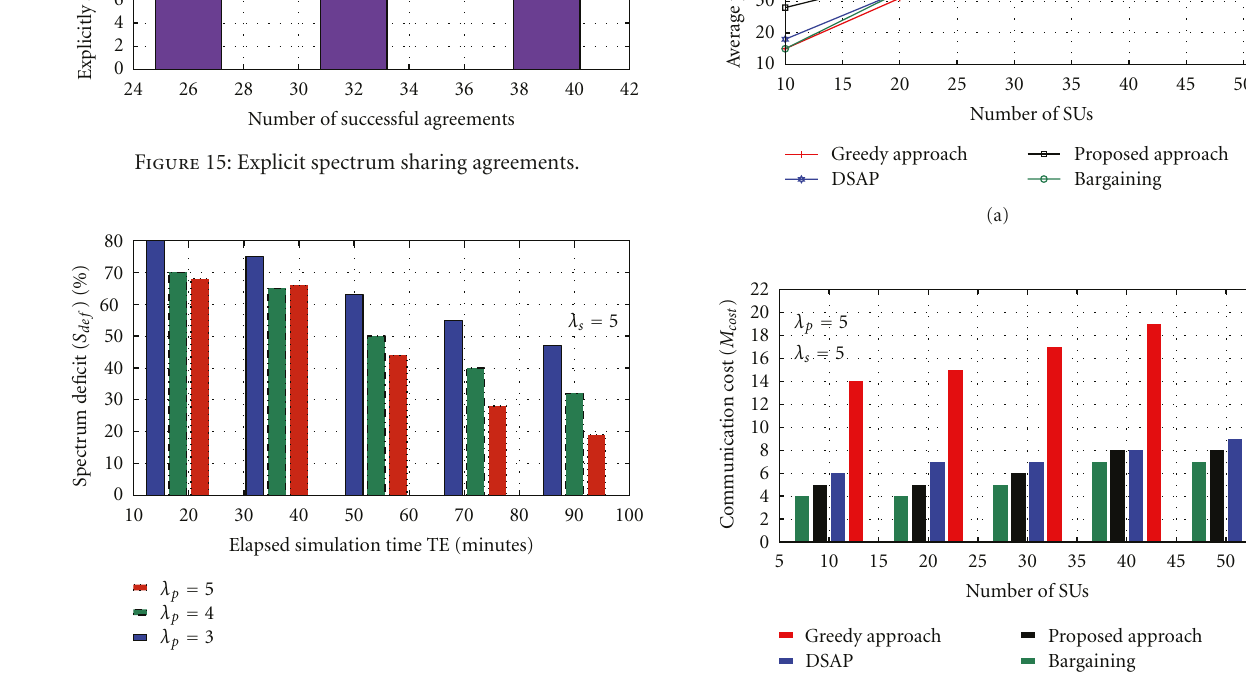
Figure 16: Spectrum deficit.